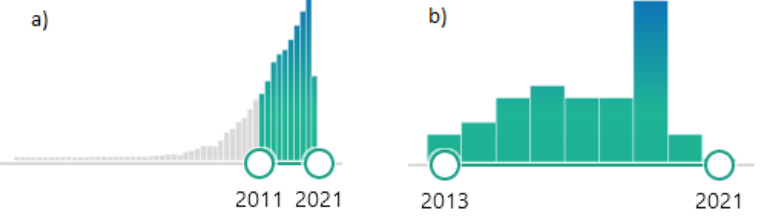
Figure 1. Number of publications in Pubmed (search performed in April 2021): ( a ) keywords: “polysaccharides hydrogels” ( b ) keywords: “cartilage tissue engineering, hydrogel, polysaccharide, 3D printing”.